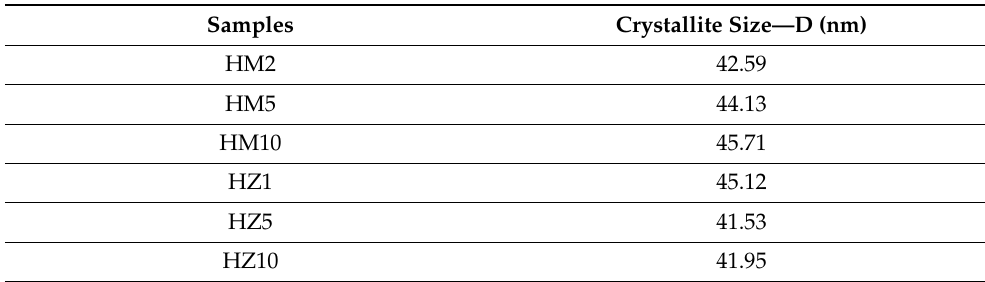
Table 1. Values obtained by calculating the mean diameter of crystallite, D (nm) with the Debye– Scherrer equation. Samples